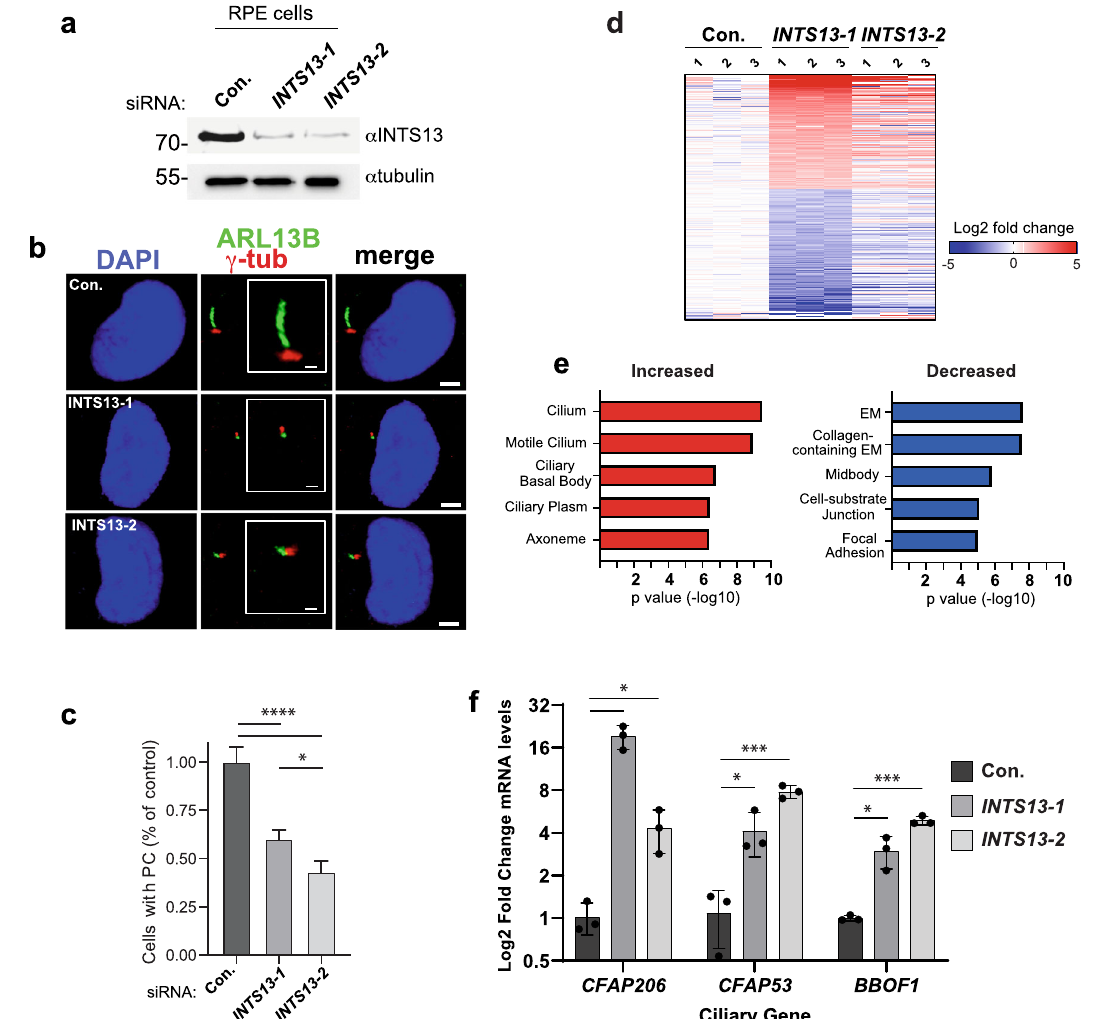
Fig. 5 | INTS13 depletion leads to a loss of primary cilia and broad transcrip- tionalperturbationofciliarygenes.a WesternblotofwholecelllysatesfromRPE cells treated with non-targeting control siRNA (Con.) or either of two siRNA tar- geting INTS13 ( INTS13-1 , INTS13-2 ).LysateswereprobedforeitherINTS13ortubulin asaloadingcontroland molecularweightmarkersshownareinkilodaltons.RNAi- depletion and Western blotting was repeated in two independent experiments with a representative image shown. b Immuno fl uorescence imaging of RPE cells treated with siRNAs as in ( a ) to visualize primary cilia (PC). DAPI staining in blue indicates the nuclei, γ -tubulin staining is shown in red to visualize the basal body, and ARL13B staining is shown in green to visualize the ciliary axoneme. Repre- sentative images show disrupted primary cilia that occurred when INTS13 was targeted byRNAi.Thescalebarforthemergedimage issetat3 μ mwhilethescale bar in the fi gure inset present in the center is 1 μ m. c Images from ( b ) were quanti fi ed for each condition and graphed as a percentage of the number of control-treatedcellswithPC(dataaremean+/-SD,con. n =3785cells,13-1 n =2969 cells, 13-2 n =2675 cells. Raw calculations for each condition were divided by the